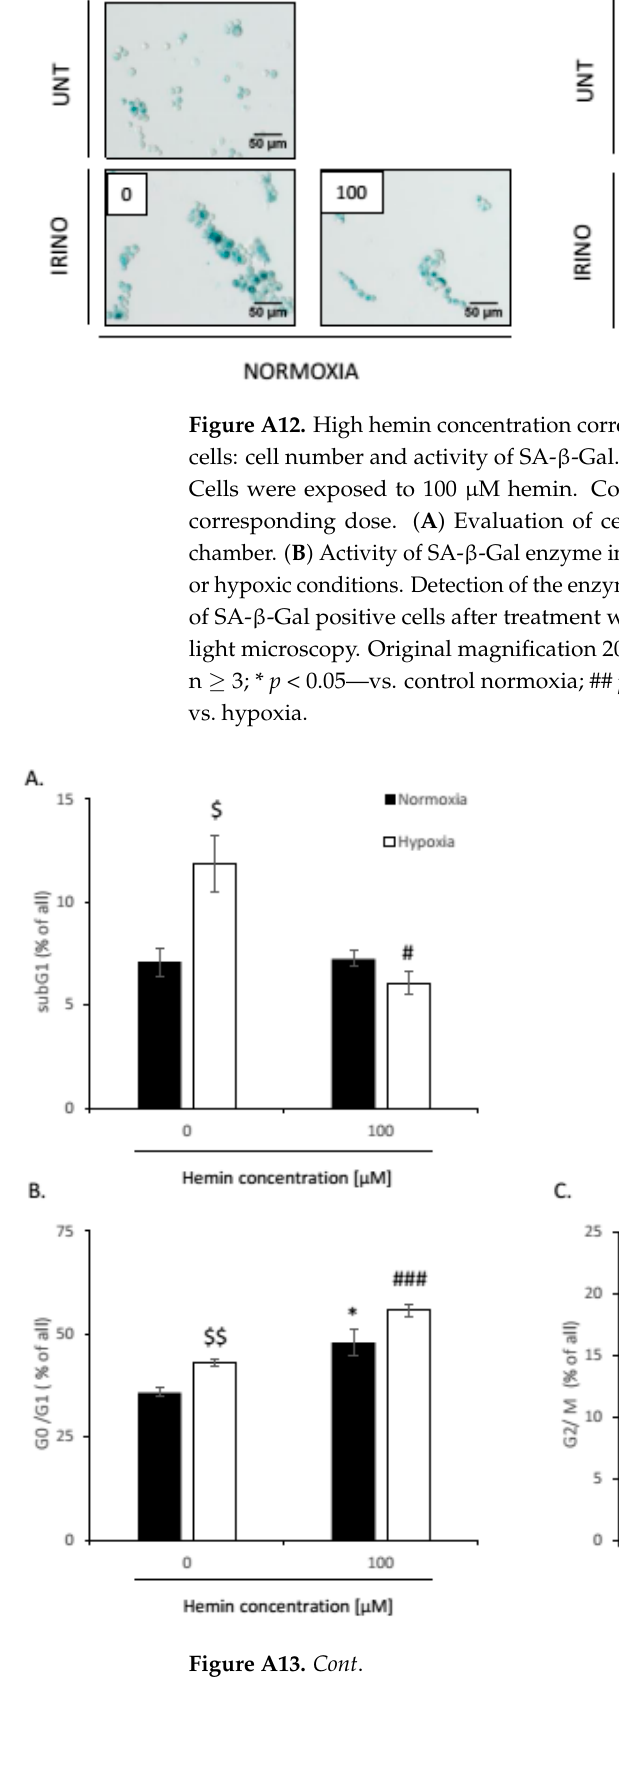
Figure A13. High hemin concentration correlates with an escape from senescence of hypoxic SW480 cells: changed accumulation in different phases of the cell cycle. Quantification of the percentage of cells in the subG1 ( A ), G0/G1 ( B ), G2/M ( C ), and S phases ( D ), and polyploid cells ( E ). Cell cycle analysis was performed with the Cell Cycle Analysis Kit (Sigma) and flow cytometry; Each bar rep- resents mean ± SEM, n ≥ 3; * p < 0.05—vs. control normoxia; # p < 0.05, ### p < 0.001—vs. control hypoxia; $ p < 0.05, $$ p < 0.01—normoxia vs. hypoxia.